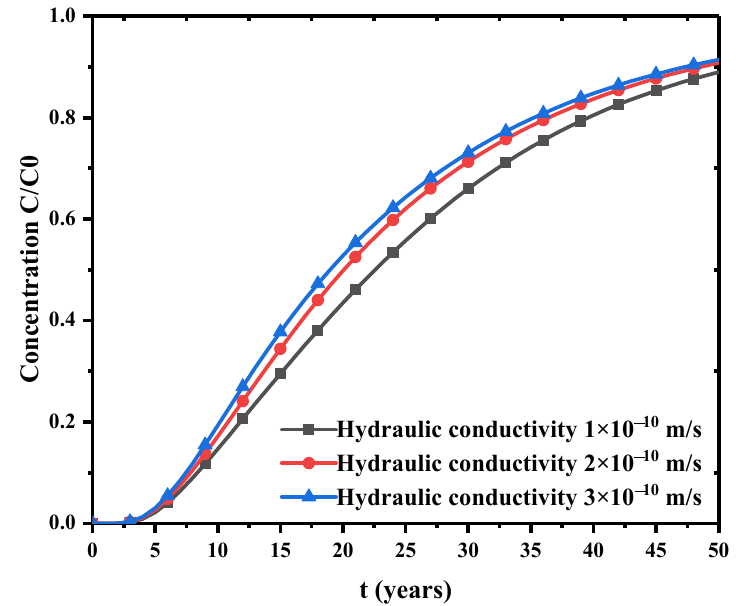
Figure 6. E ff ect of hydraulic conductivity on concentration Figure 6. Effect of hydraulic conductivity on concentration change.